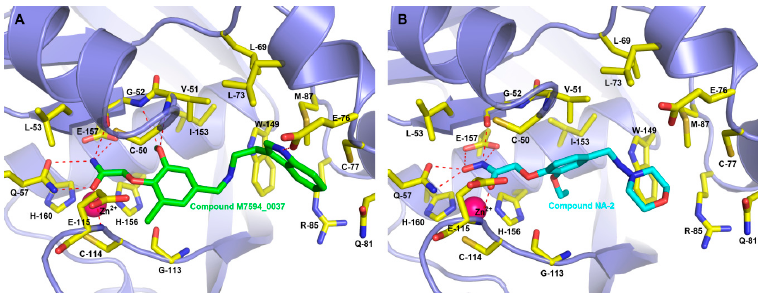
Figure 3. Depicting the binding pose of inhibitors in the HsPDF binding pocket: M7594_0037 ( a ) and NA-2 ( b ). The red color bonds indicate the hydrogen bonds between inhibitor and amino acids (colored by yellow).